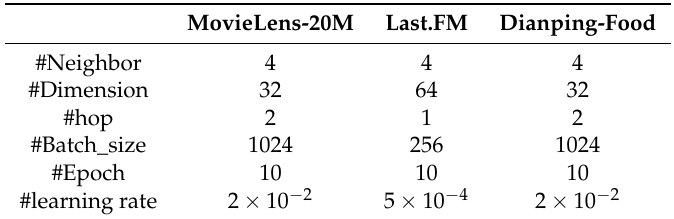
Table 3. Hyper-parameter